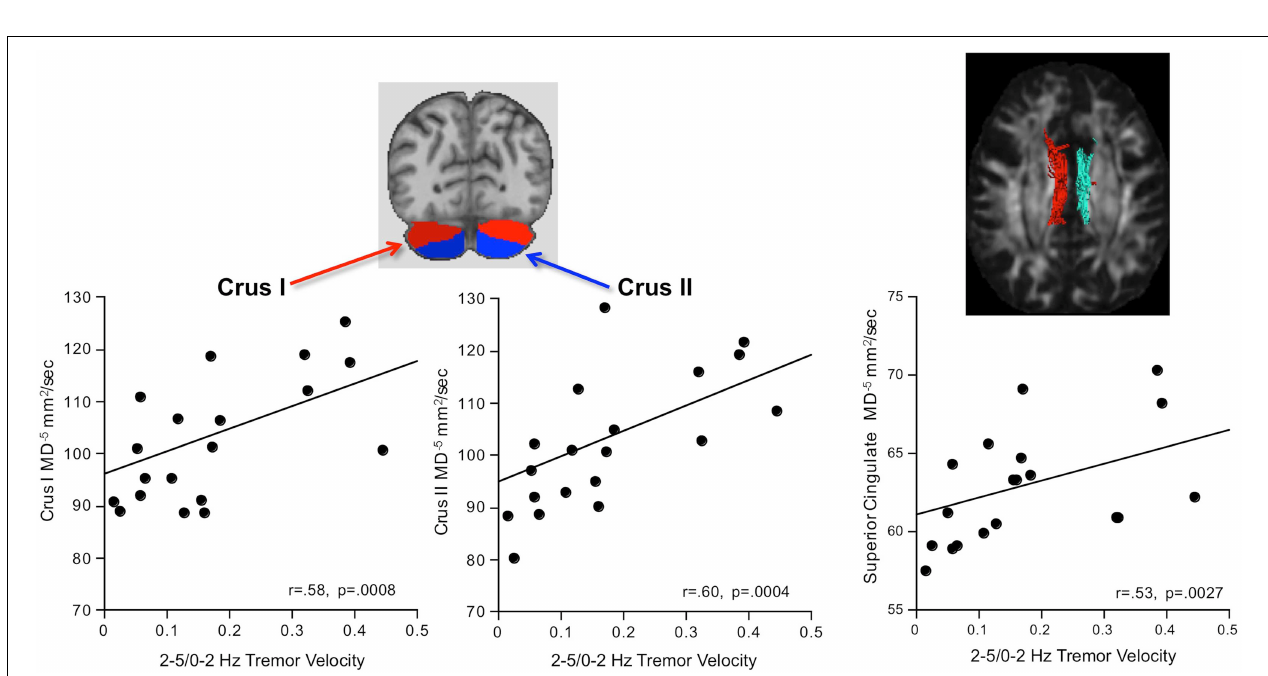
closed, hard arithmetic) for the 32 alcoholic men (black lines and filled circles) and 23 control men (gray lines and squares). Spectra from the anterior-posterior plane and the medial-lateral plane are plotted